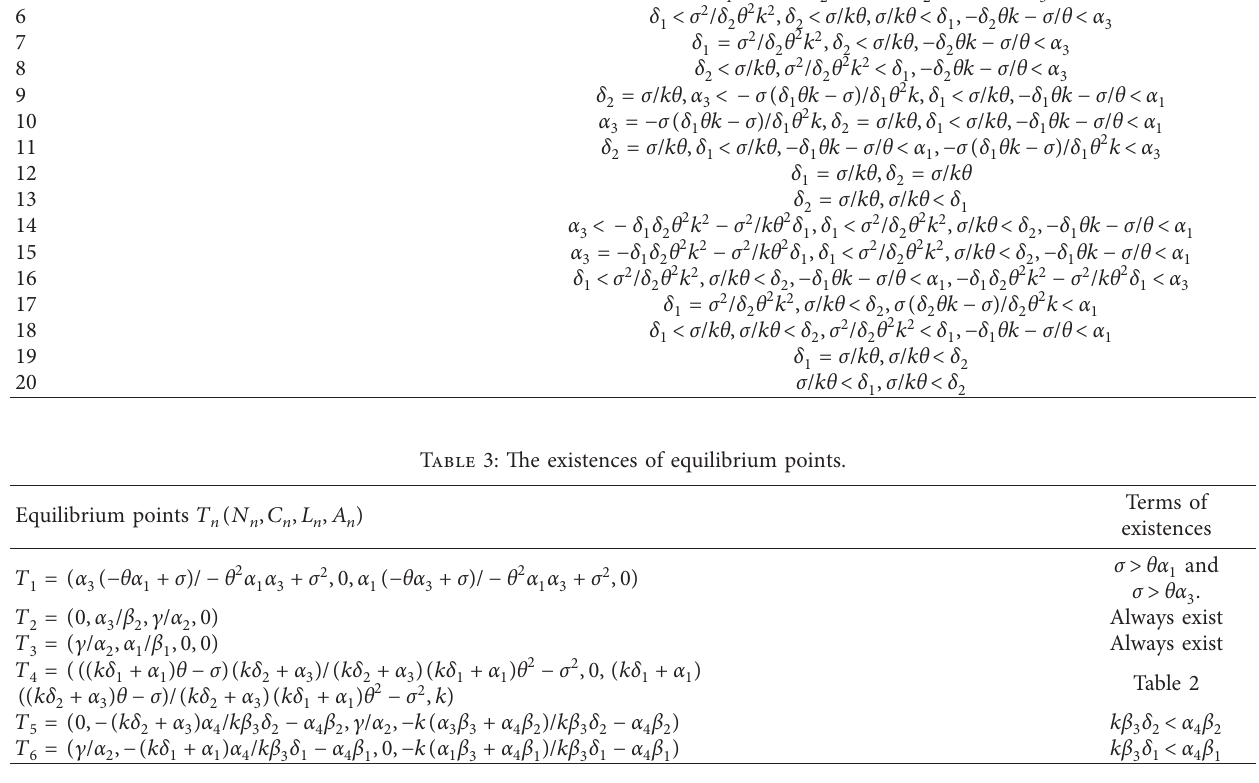
Table 4: Coexistence of the equilibrium points T